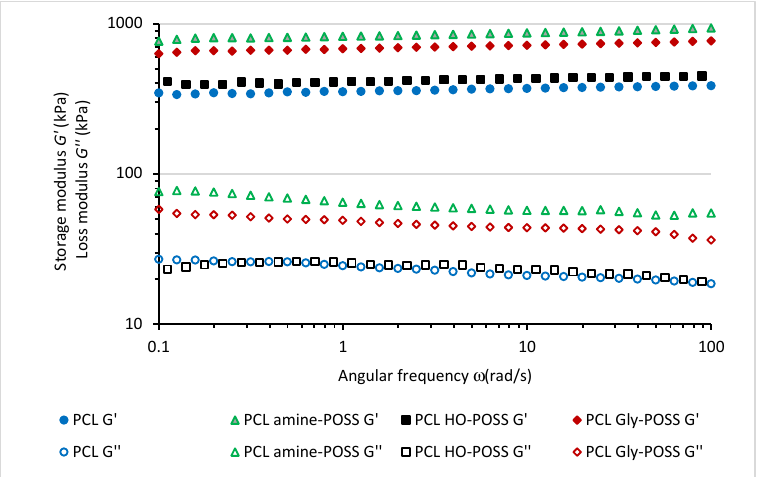
Figure 3. Storage modulus G ′ , loss modulus G ″ as a function of angular frequency (rad ⋅ s-1) for PCL samples. Temperature of the measurements 25 ° C, oscillation strain 0.02 (%).